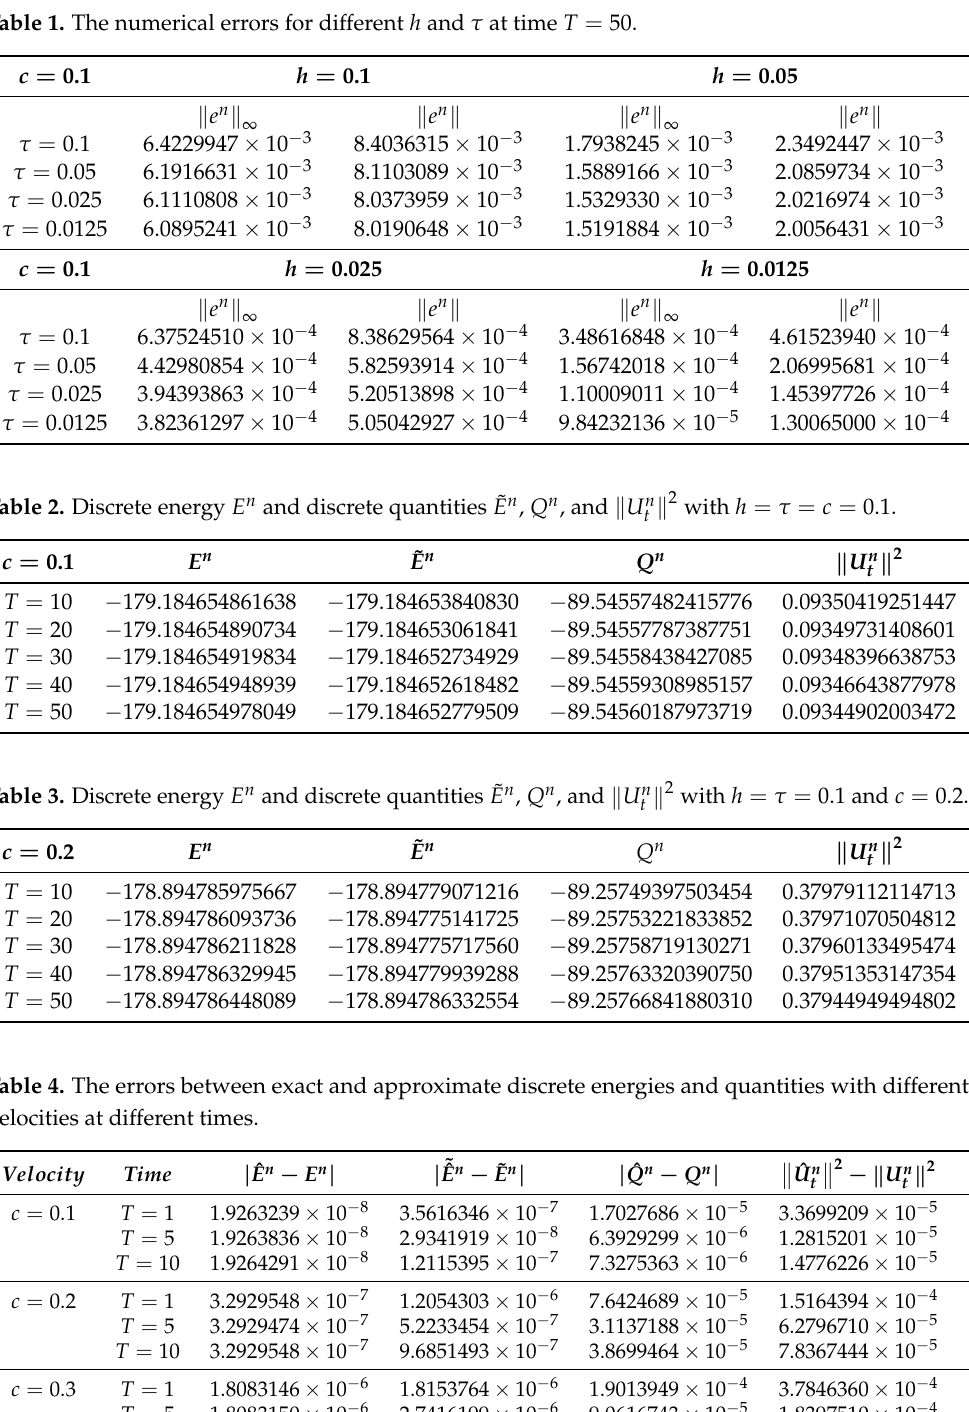
Table 1. The numerical errors for different h and τ at time T = 50.